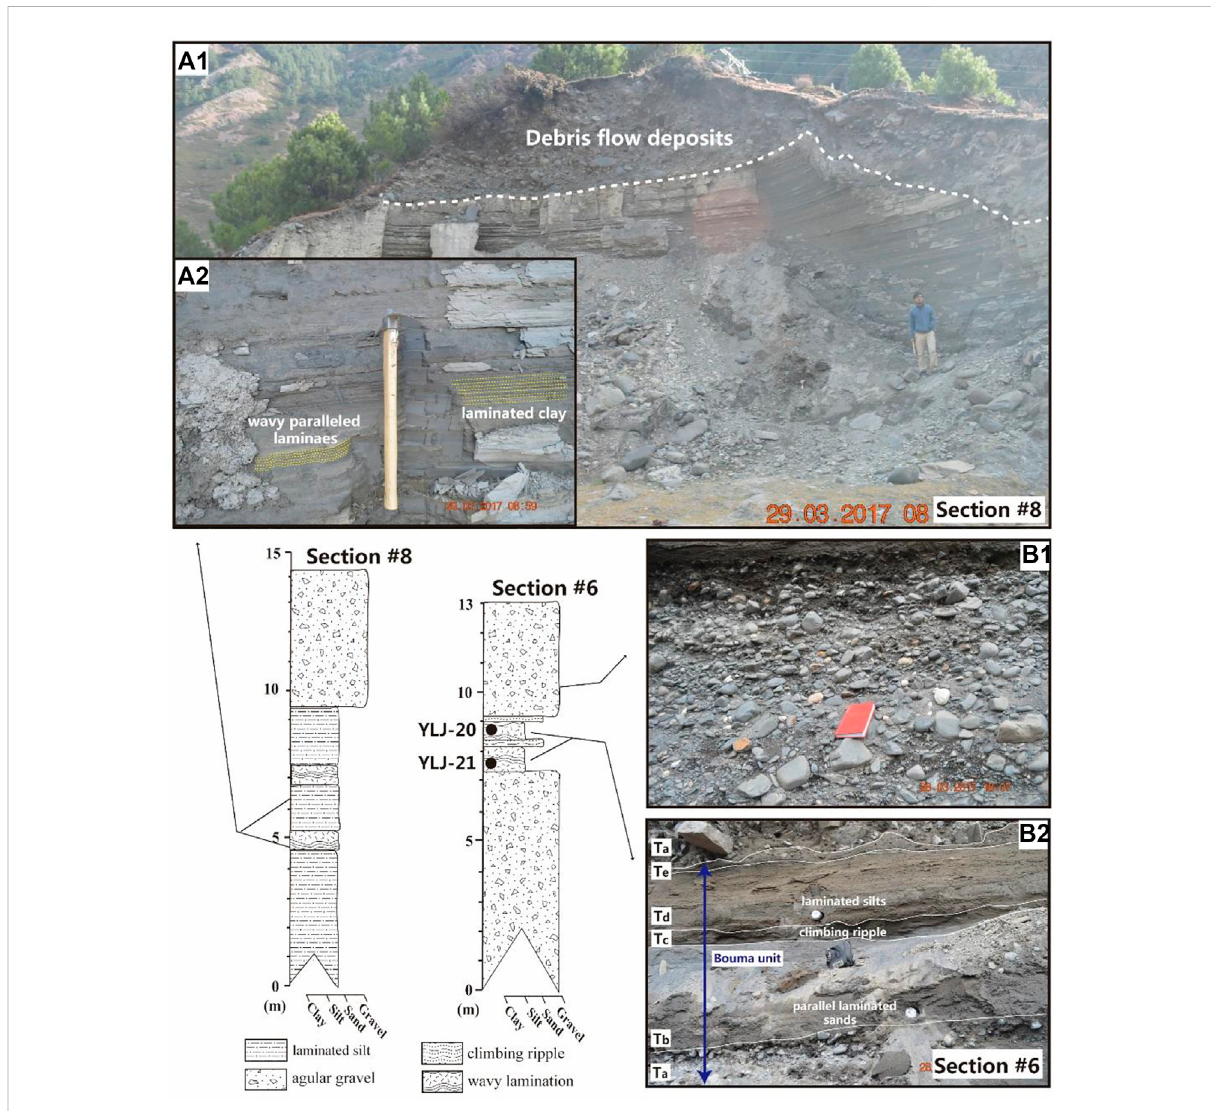
FIGURE 5 Detailed sedimentary logs and photographs of lacustrine sections #6 and #8 in the Yuting landslide-dammed lake. (A1) Macroscopic sedimentary features of section #8. (A2) Wavy parallel laminae and climbing ripples from section #8. (B1) Debris fl ow sediments in the upper part of section #6. (B2) Typical Bouma sequence in the middle of section